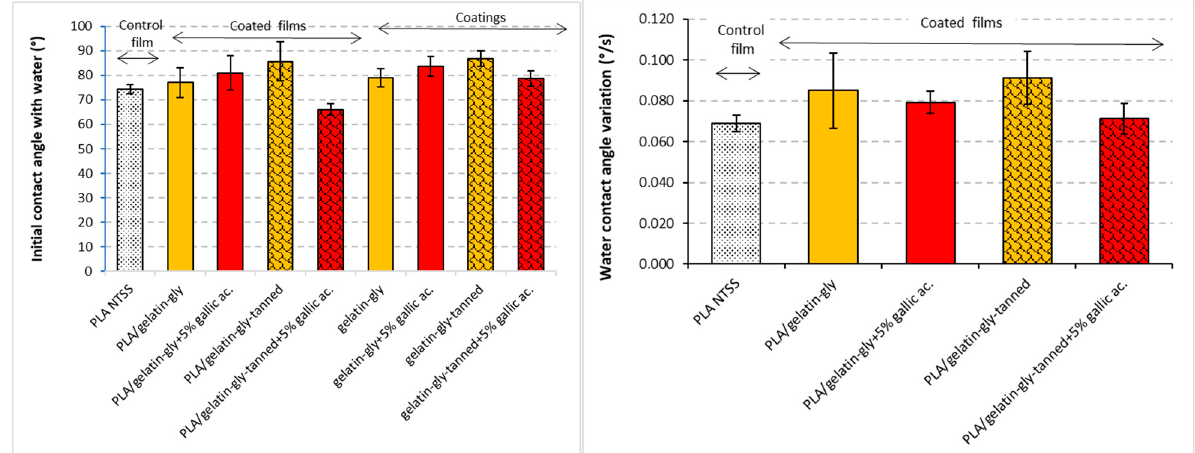
Figure 8. Surface properties (initial value and variation of water contact angle) of PLA, standalone coatings and coated PLA films measured at 25 °C and 50% RH.